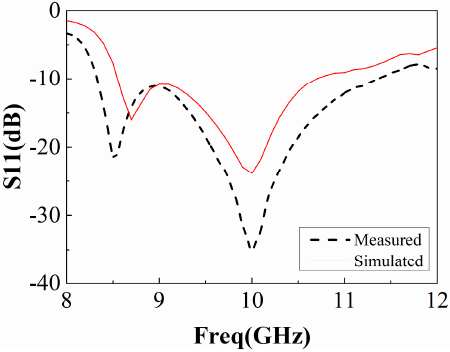
Figure 19. Measurement and simulation of F-P antenna S11.